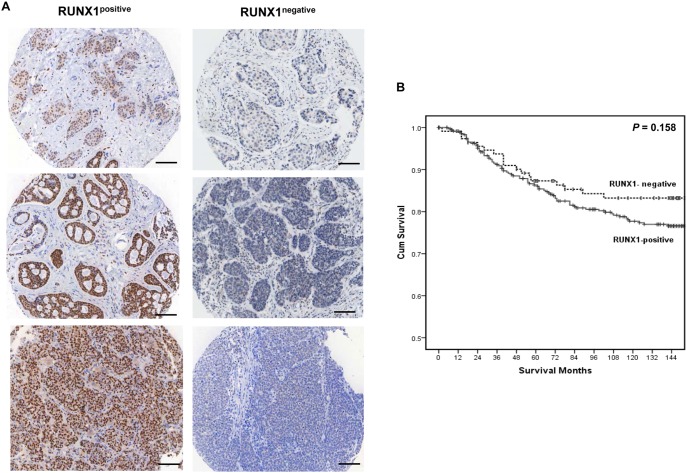
RUNX1 expression and cancer-specific survival in primary operable breast cancer.(A) Representative examples of invasive breast carcinomas in a tissue microarray containing 483 breast cancers which were positive (left) and negative (right) for RUNX1 expression. Note the nuclear staining in the tumour epithelium. Scale bar represents 100 µm. (B) The association between the absence and the presence of RUNX1 and cancer-specific survival in primary operable breast cancer (n = 483). Survival curves are plotted for patients with cancers scored positive for RUNX1 (solid line), or negative for RUNX1 expression (dotted line). P>0.1, P-value calculated using Log Rank (Mantel-Cox) test.